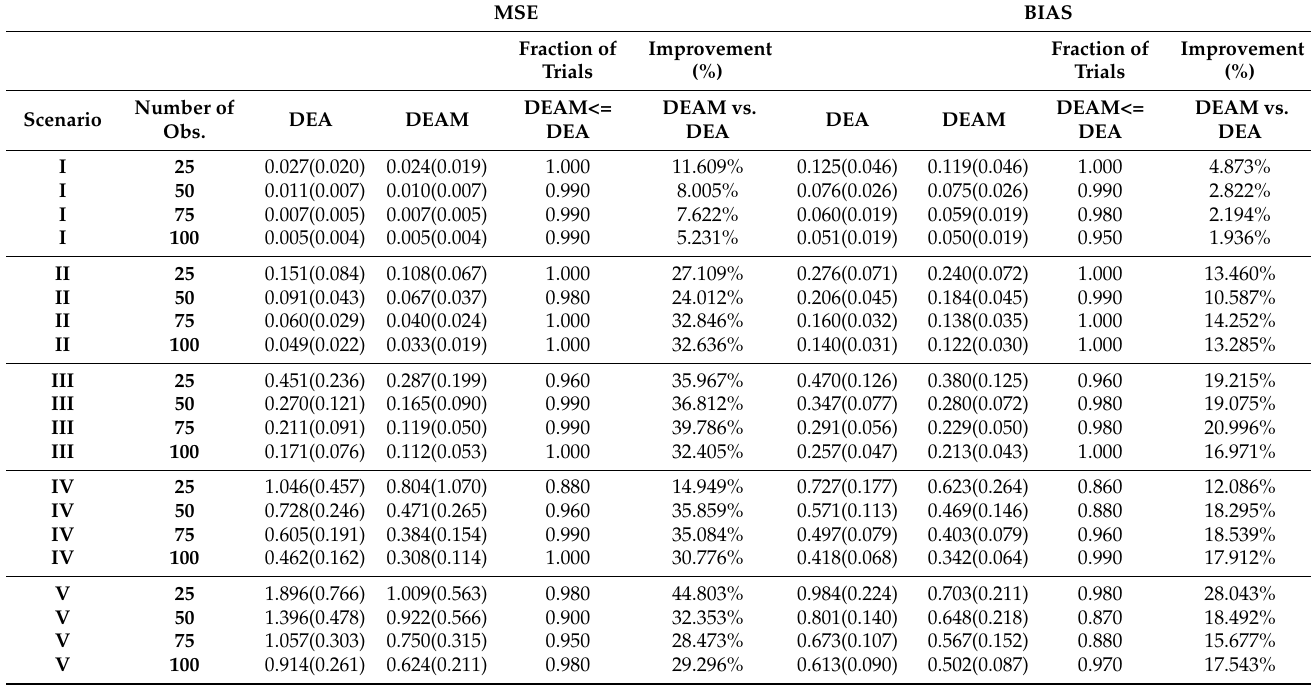
Table 2. Performance of DEA and